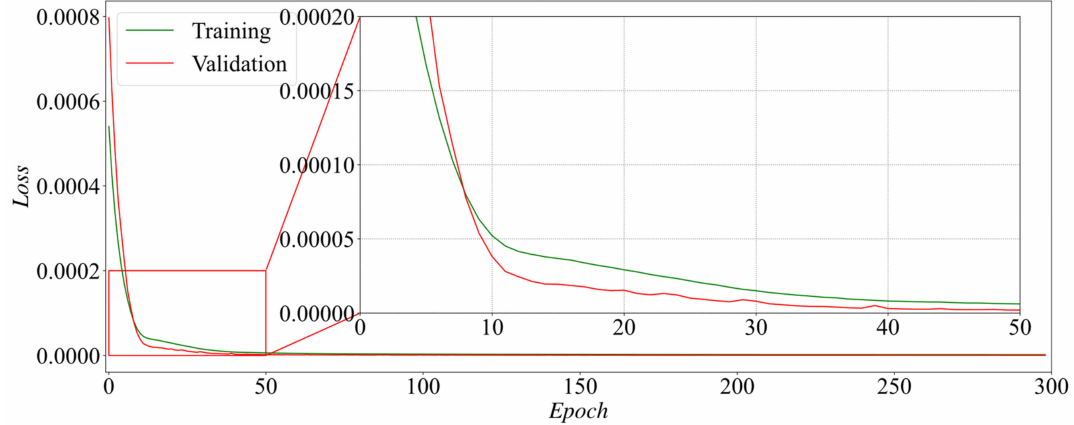
Figure 10. State prediction model loss trends for training and validation sets ( ω m ).